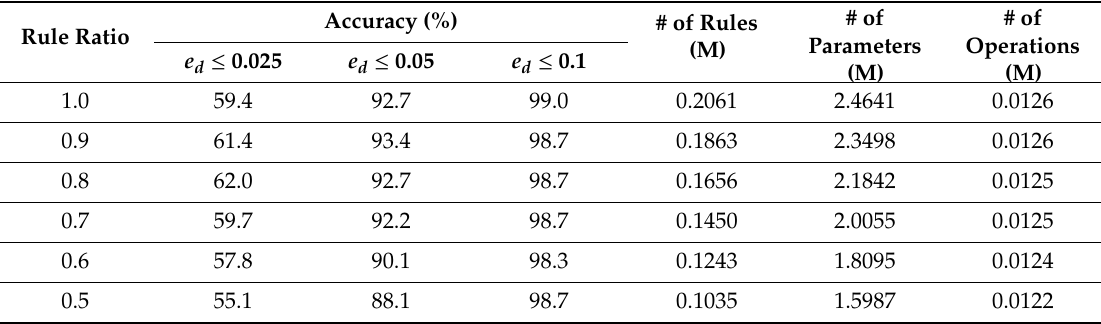
Table 3. Performance evaluation results in terms of accuracy and numbers of rules, parameters, and operations of the proposed method according to changes in the rule distillation when using the BioID dataset.